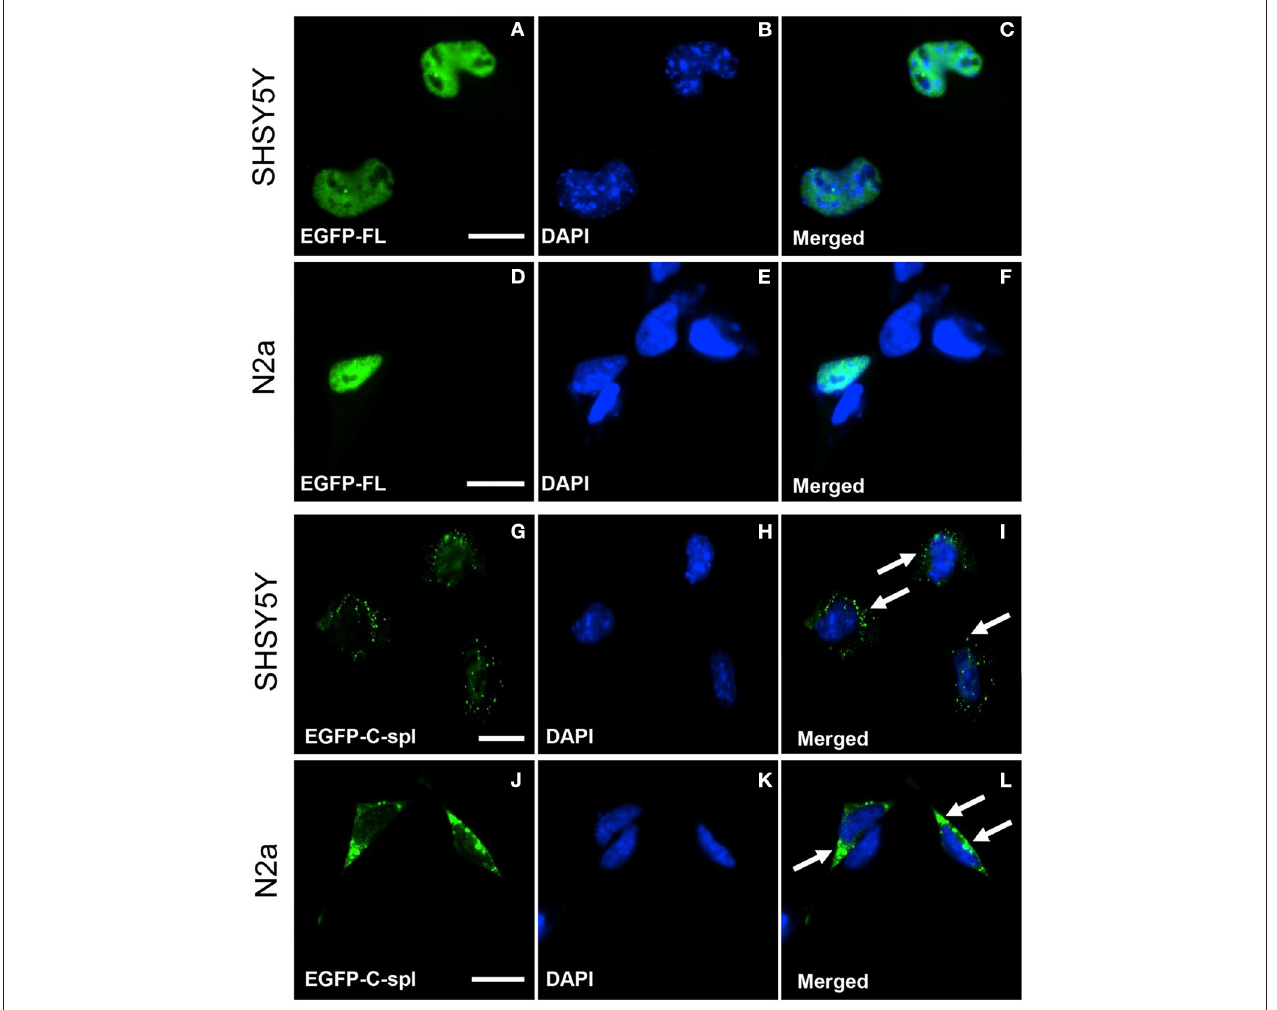
FIGURE 4 | Subcellular localization of TDP43-FL and TDP43C-spl in neuronal cells. SHSY5Y (human neuroblastoma) and N2a (mouse neuroblastoma) cells were transfected with EGFP-tagged TDP43-FL (A–F) or EGFP-tagged TDP43C-spl (G–L) . The EGFP-tagged TDP43-FL (A,D) and blue DAPI nuclear stain (B,E) showed co-localization to the nucleus in both SHSY5Y cells (C) and N2a cells (F) . EGFP-tagged TDP43C-spl was localized to the cytoplasm in both SHSY5Y cells (G) and N2a cells (J) , with no co-localization with DAPI [ (H,K) , with overlays shown in (I,L) ]. Cytoplasmic localization of aggregate TDP43C-spl is shown by arrows in (I,L) . Scale bars = 15 µ